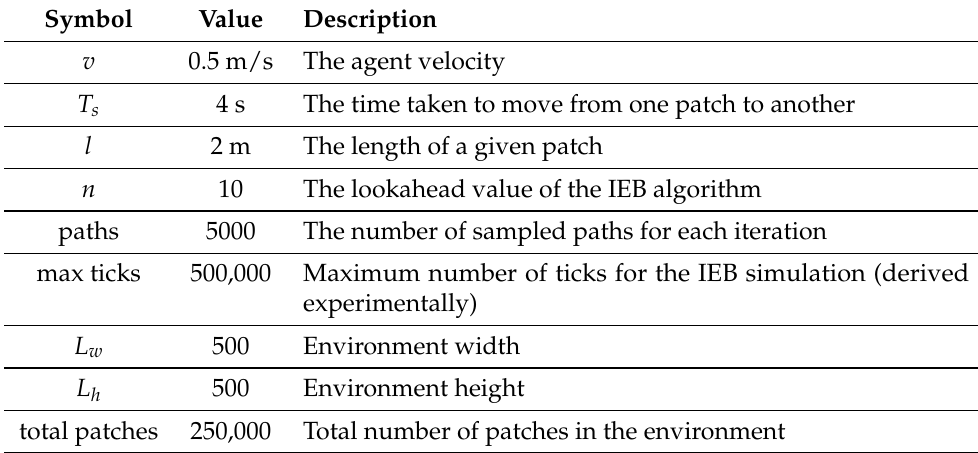
Table 1. A list of fixed parameters used in